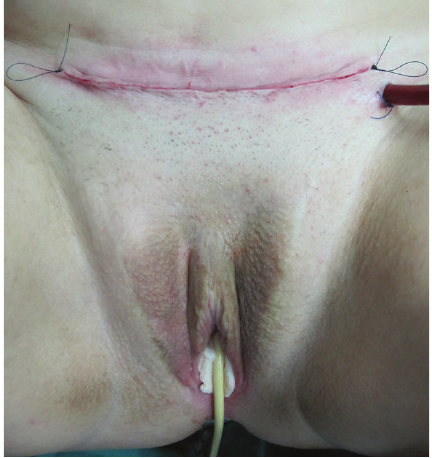
Figure 10: Appearance at the end of